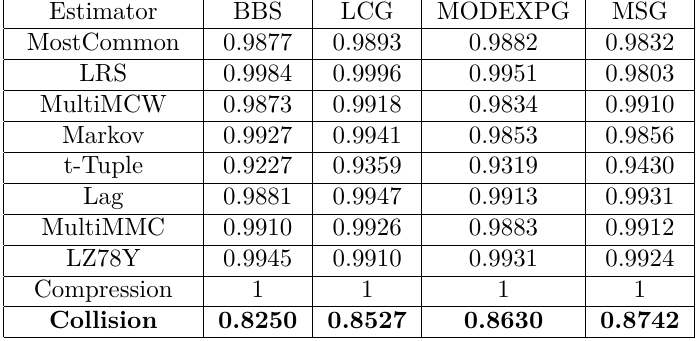
Table 3: Entropy estimates for (almost) perfectly random data generated by different